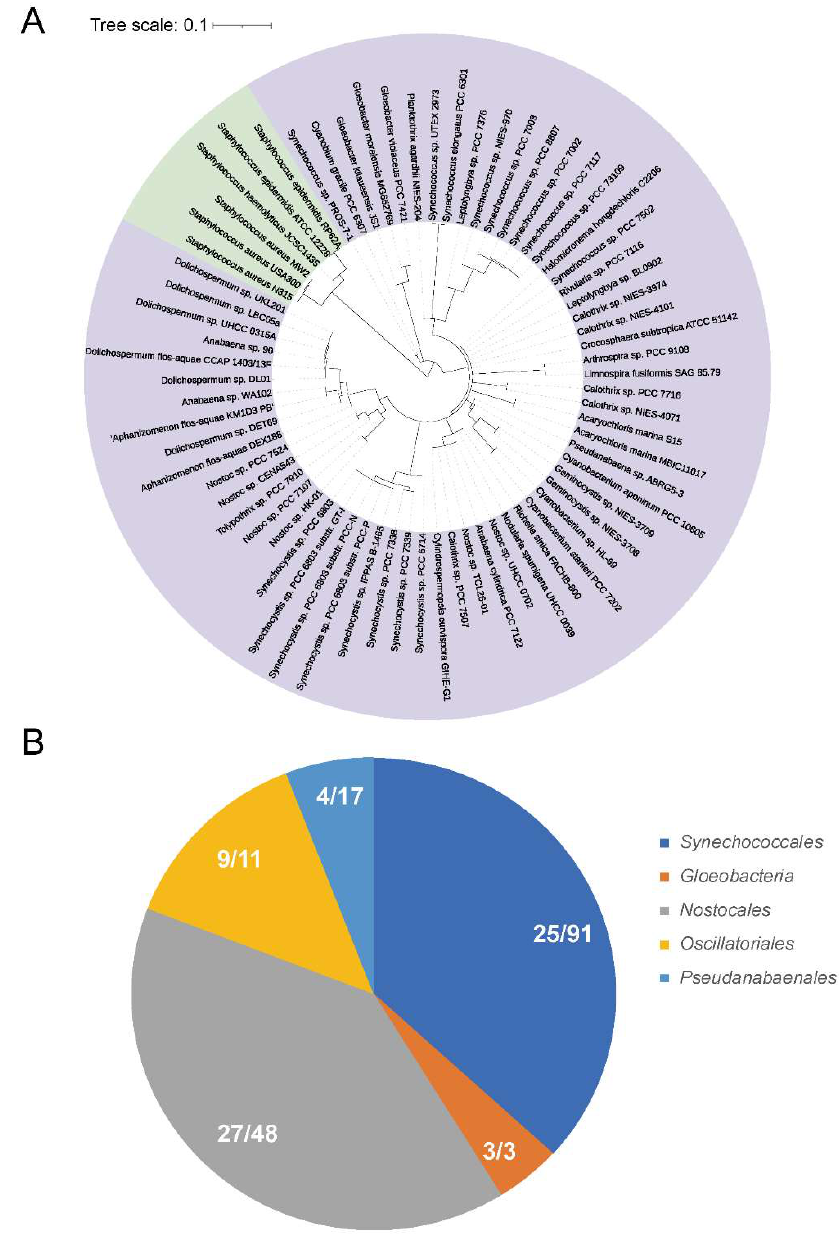
Figure 1. Phylogenetic analysis of PerR-encoding genes in the sequenced cyanobacteria genomes. ( A ) Phylogenetic tree of PerRs in cyanobacteria. A total of 68 probable PerRs were found